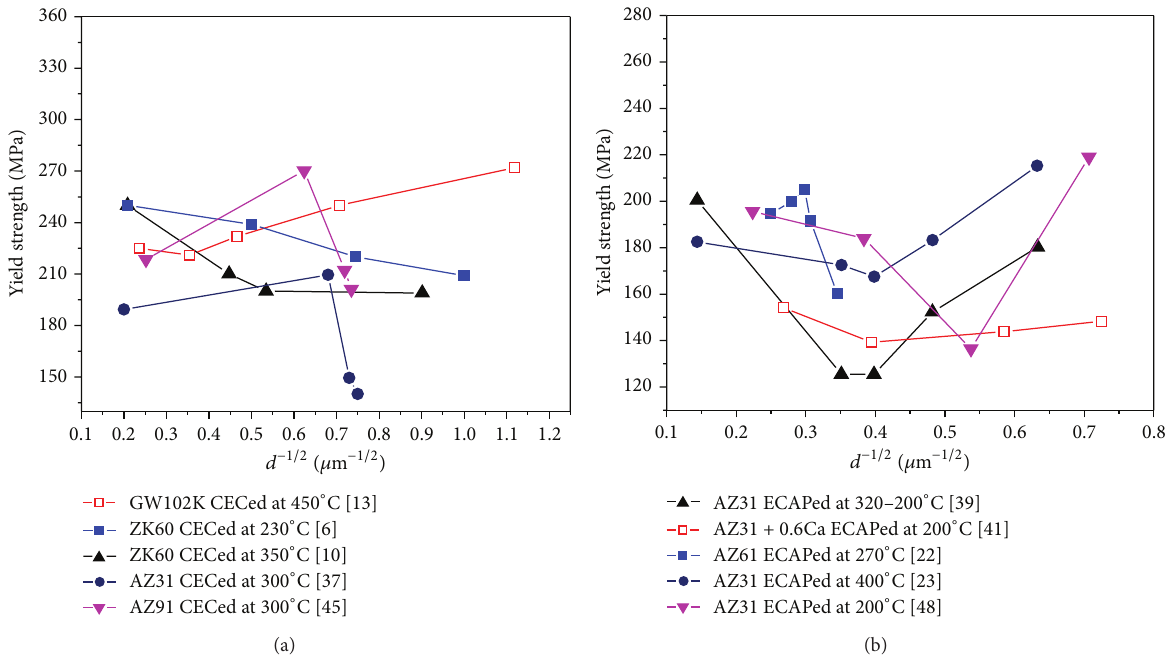
Figure 6: Grain size dependencies of yield strength of Mg alloys processed by (a) CEC and (b)